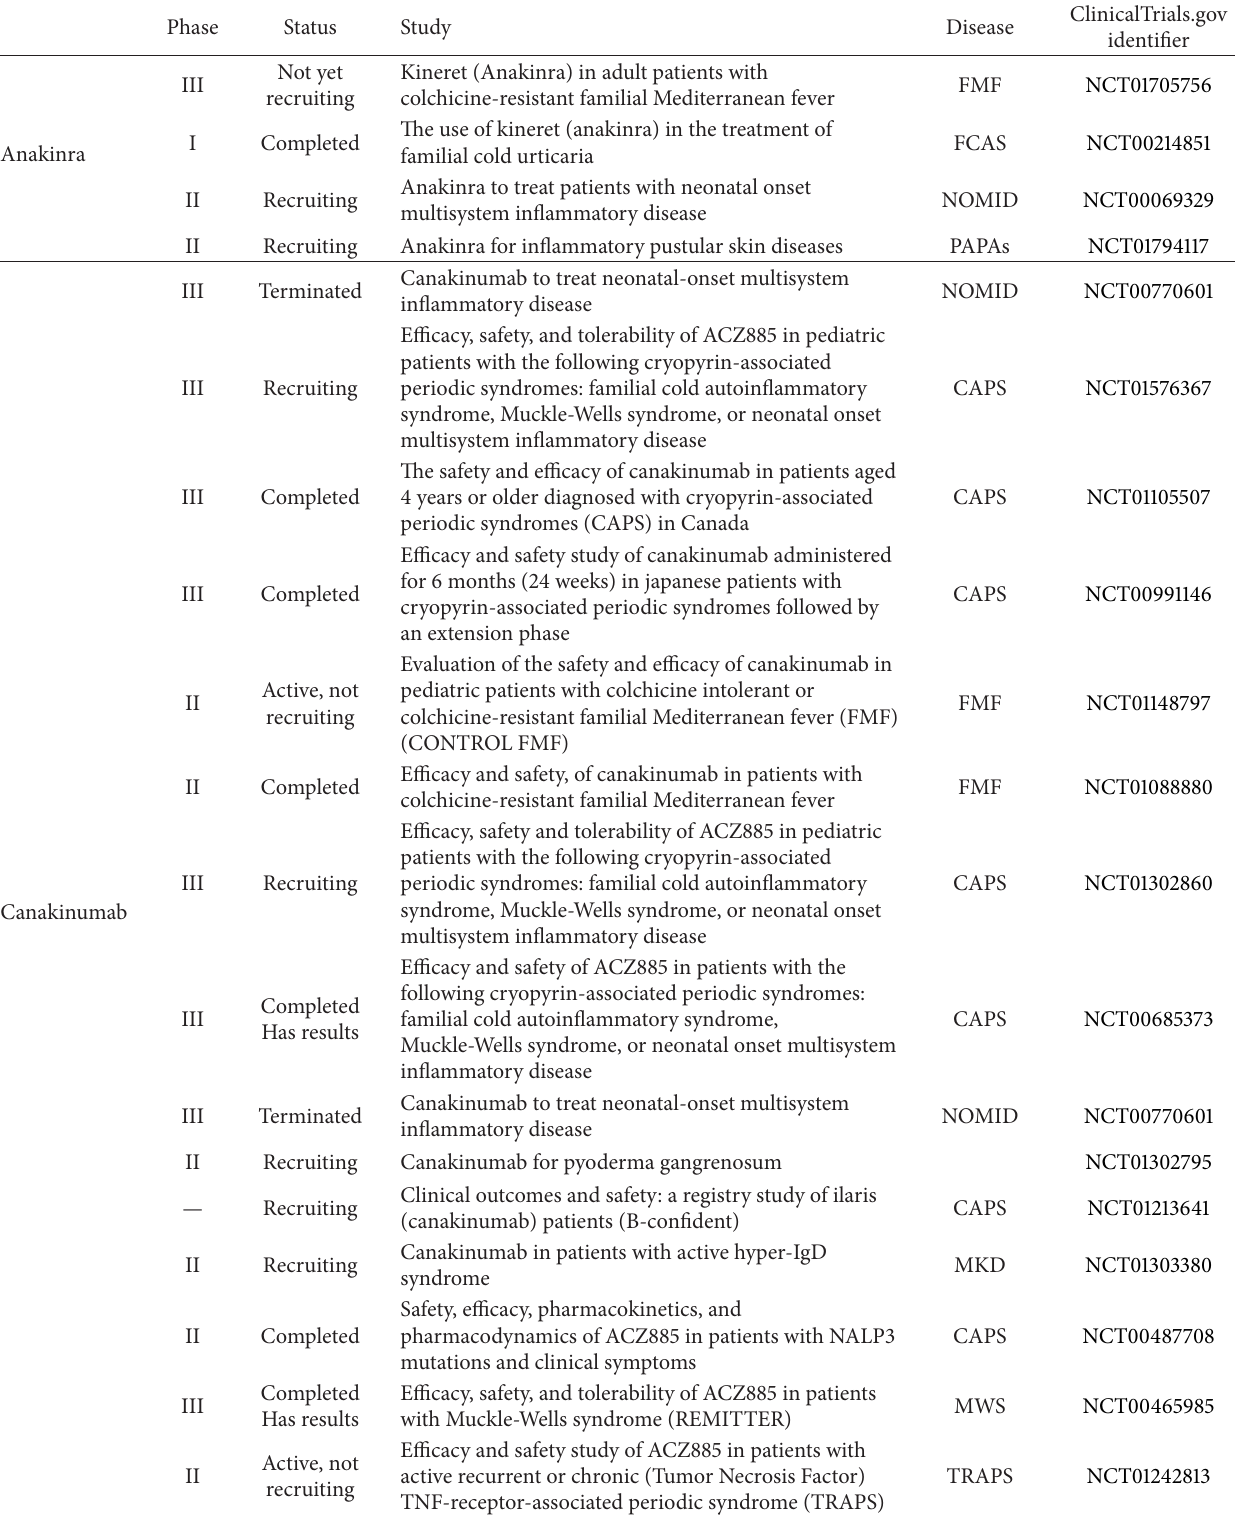
Table 2: Recent and ongoing clinical trials on biologic treatments in the monogenic autoinflammatory disorders.